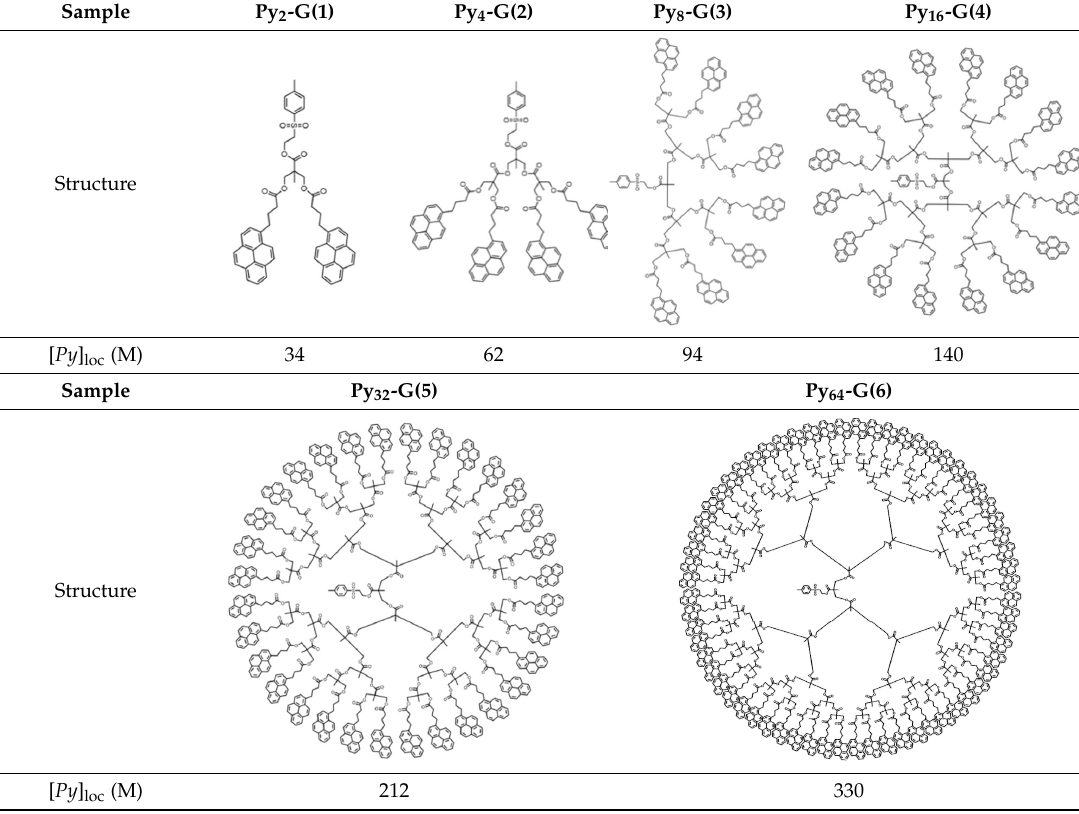
Table 1. Chemical structure and [ Py ] loc for each Py x -G( N ) dendron [29].